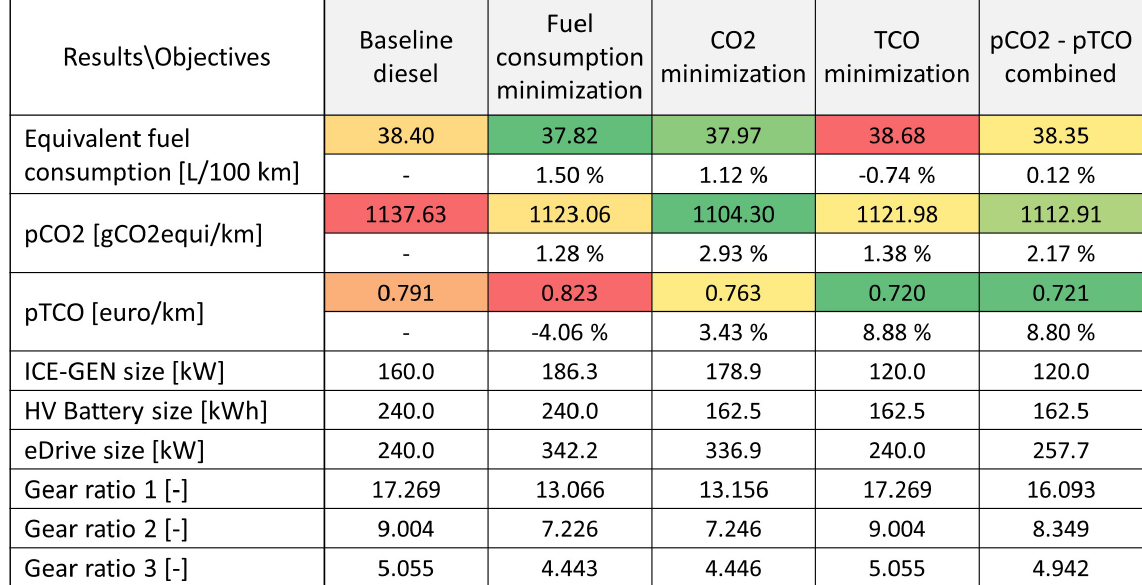
Figure 8. Quantitative comparison of diesel − fueled powertrain size solutions running on VECTO interurban cycle focused on minimisation of fuel consumption, carbon footprint ( pCO 2 ), lifetime costs ( pTCO ) and environmental-economic balanced objective ( pCO 2 − pTCO ) against the baseline case. The corresponding choice of optimised powertrain dimensions have also been